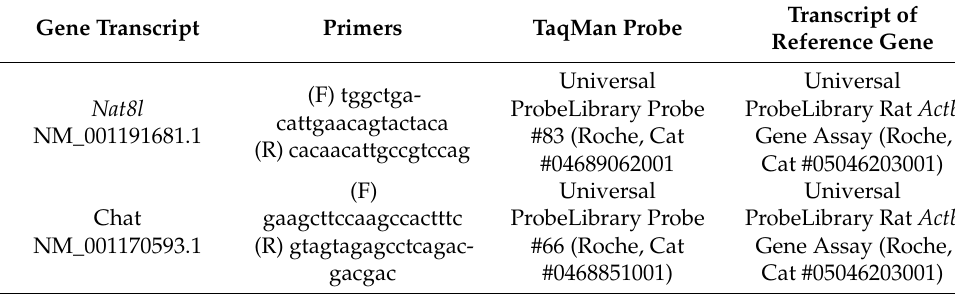
Table 2. A list of primers and TaqMan probes used in this